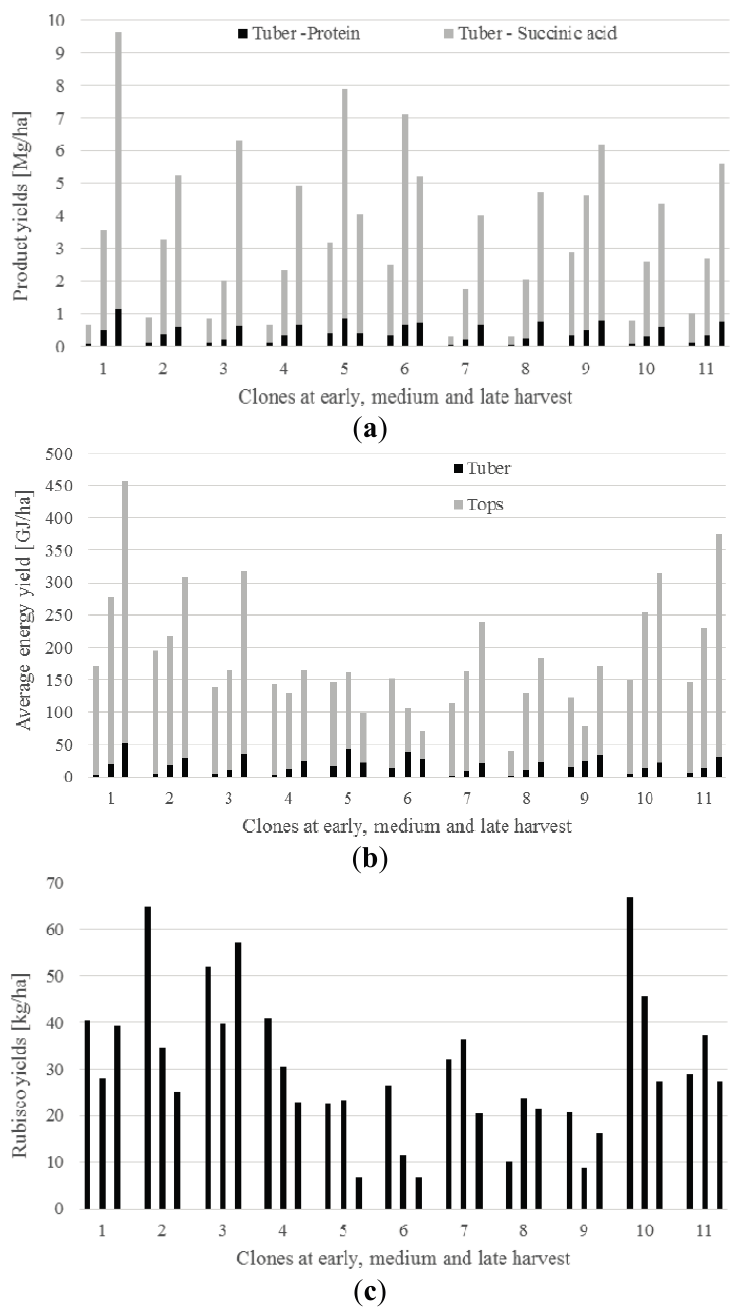
Figure 1. Average yields of ( a ) protein and succinic acid from tubers, ( b ) energy from biogas production of fermentation and extraction residues from tubers and tops, and ( c ) rubisco protein from tops, for different clones of Jerusalem artichoke harvested at early (September), medium (October) and late (December) harvest